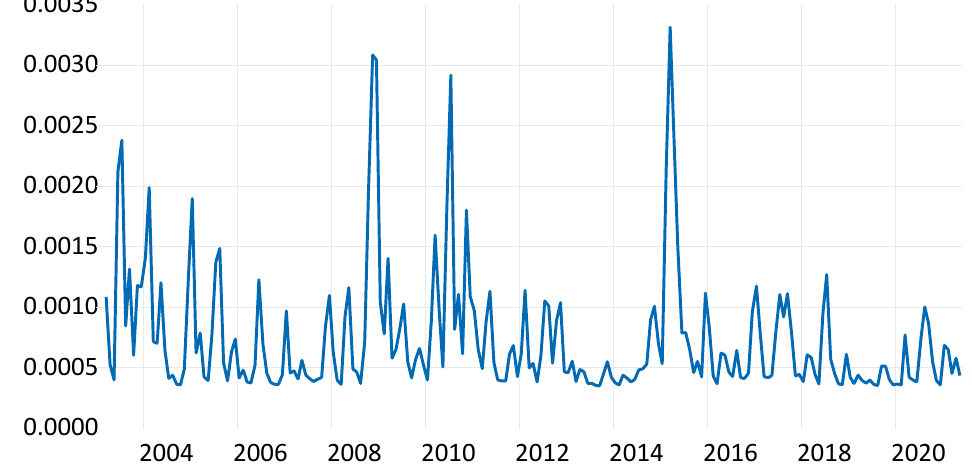
F igure 1. USD/EUR real exchange rate volatility. Figure 1. USD/EUR real exchange rate volatility.